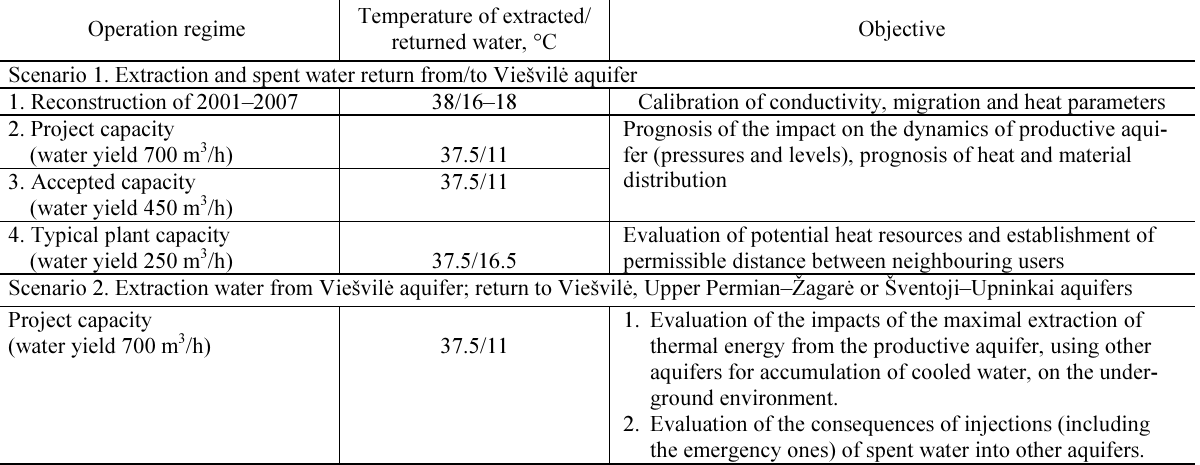
Table 2. Modelled geothermal plant operation scenarios and their objectives Operation